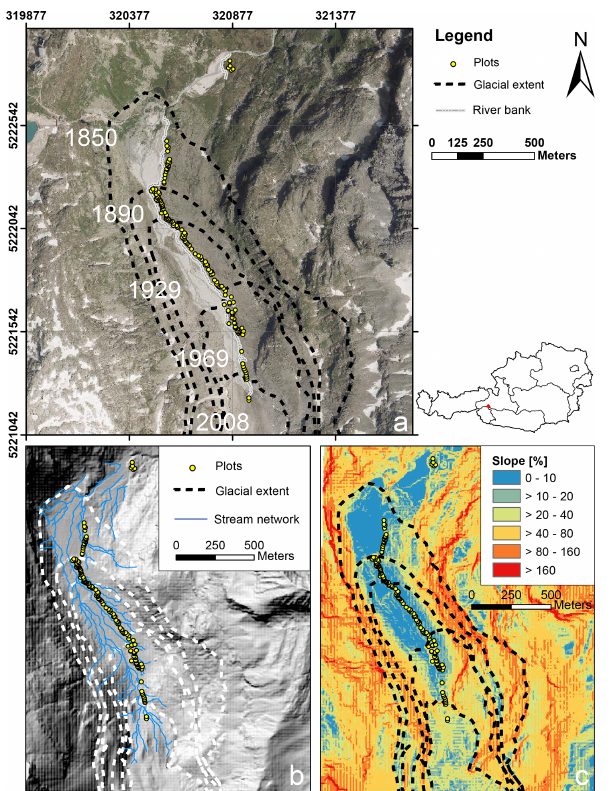
Figure 1. Study area and plot location along the Ödenwinkel- kees valley. (a) Location of the permanent plots along the glacier forefield. The glacial extents at different time points are given as dashed lines (orthophoto data source: http://basemap.at, last ac- cess: January 2020). (b) Digital elevation model (DEM) with mod- eled stream network (DEM data source: © SAGIS). (c) DEM with the spatial distribution of slope angles in the study area. Angles are expressed as a percentage (45 ◦ = 100%; DEM data source: ©